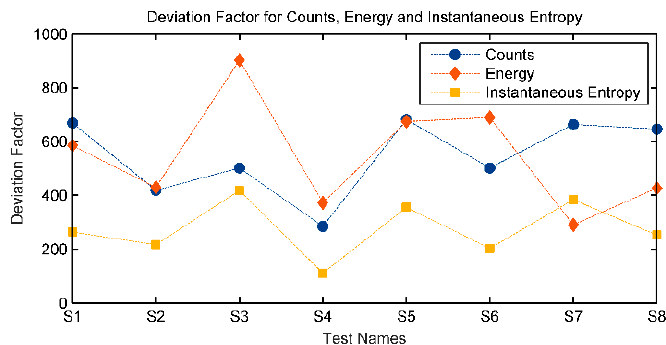
Figure 10. Deviation factor for AE counts, energy, and instantaneous entropy for all